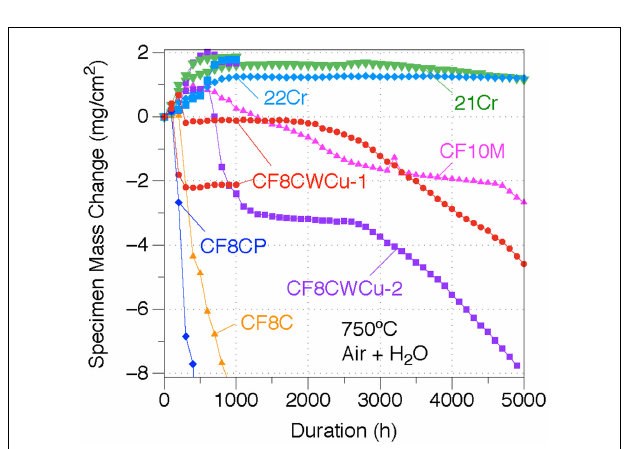
FIGURE 7 | Mass change curves for alloys CF8C, CF8CP, CF10M, CF8CWCu-1, CF8CWCu-2, 21Cr–15Ni, and 22Cr–17.5Ni exposed in air +++ 10% H 2 O at 750°C for 1000 and/or 5000h